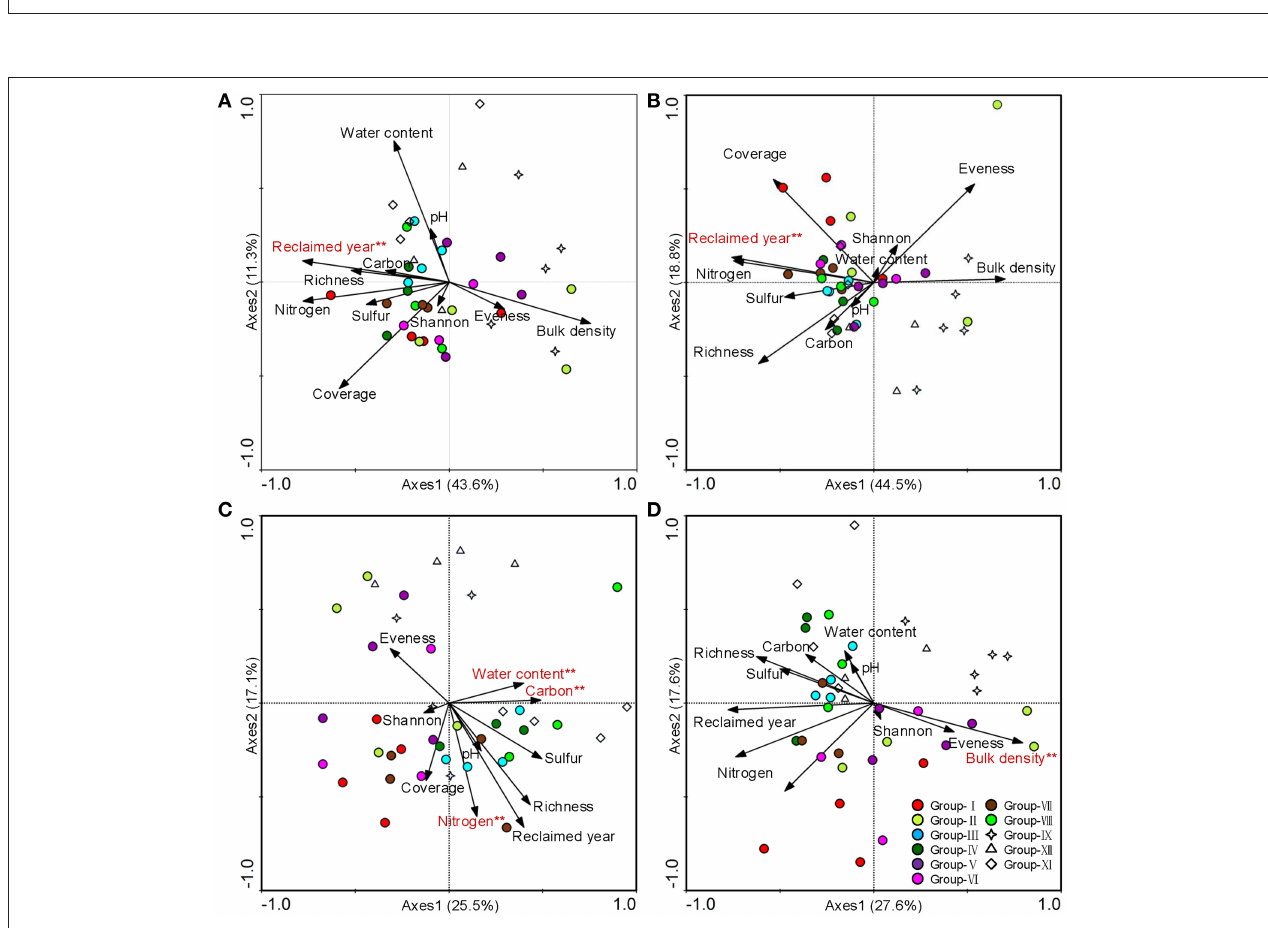
FIGURE 3 | CCA ordination biplot of 41 quadrats and environmental factors for microbial communities in the reclaimed mining area. (A) Bacteria, (B) Archaea, (C) Fungi, and (D) Total microbe. ** Significant environmental factor at the 0.01 level (Monte Carlo permutation test).